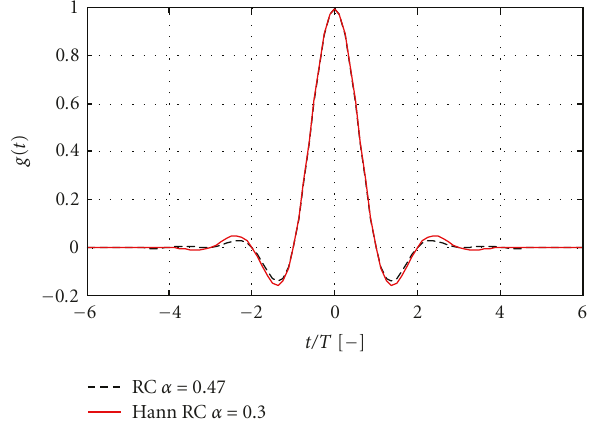
Figure 3: Graphical comparison of the impulse responses of the studied filters.